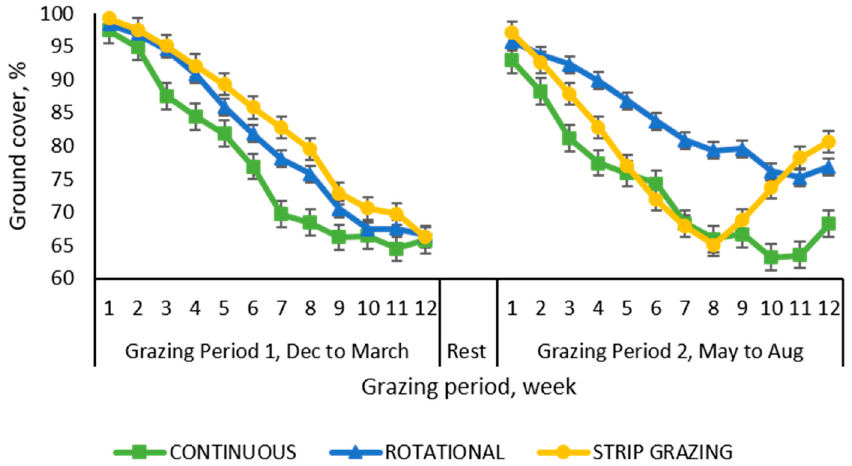
Figure 9. Weekly evolution of the vegetative ground cover in tall fescue paddocks managed with growing-finishing pigs under three different stocking methods. Data are the means of three field replicates. Errors bars represent plus or minus one standard error of the means.